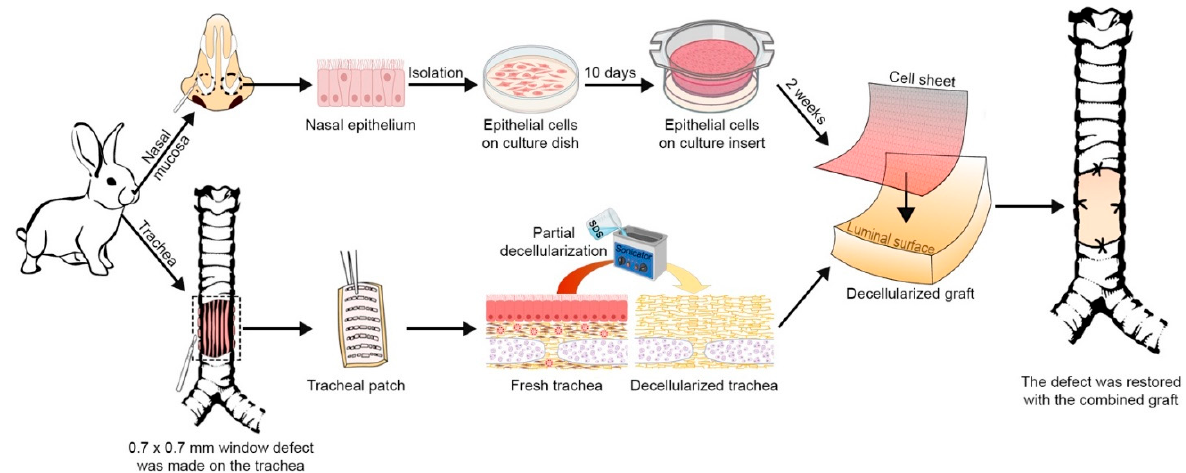
Figure 1. Flow diagram of the research design.